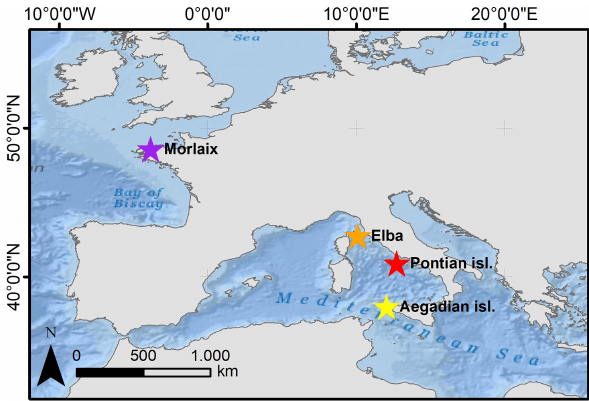
Figure 1. Map showing the distribution of sampling sites where Lithothamnion corallioides samples were collected: Morlaix Bay (48 ◦ 34 (cid:48) 42 (cid:48)(cid:48) N, 3 ◦ 49 (cid:48) 36 (cid:48)(cid:48) W), Aegadian Islands (37 ◦ 97 (cid:48) 36 (cid:48)(cid:48) N, 12 ◦ 14 (cid:48) 12 (cid:48)(cid:48) E), Elba (42 ◦ 44 (cid:48) 56.4 (cid:48)(cid:48) N, 10 ◦ 07 (cid:48) 08.4 (cid:48)(cid:48) E), and Pon- tian Islands (40 ◦ 54 (cid:48) N, 12 ◦ 45 (cid:48) E). Service layer credits: source Esri, GEBCO, NOAA, National Geographic, Garmin, https://www. geonames.org/ (last access: 21 December 2021), and other contrib-